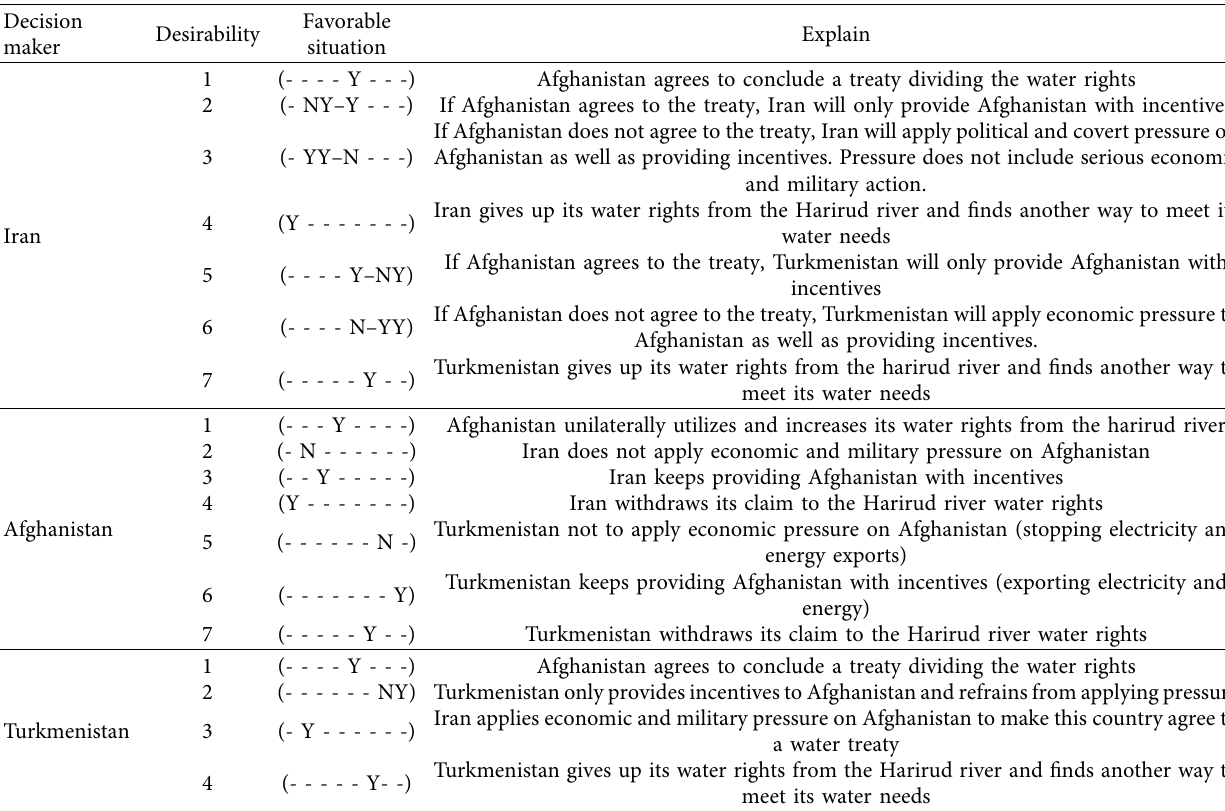
Table 4: Decision makers’ preference of feasible states in the current scenario (important to least).